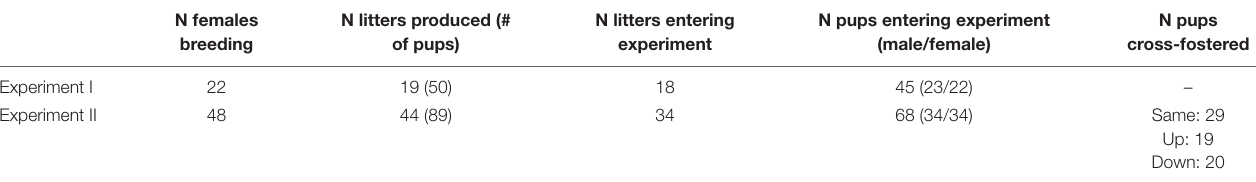
TABLE 1 | Overview of the number of females used for breeding (N females breeding), the number of females that gave birth (N litters produced) and number of pups in brackets. N females N litters produced (# N litters entering N pups entering experiment breeding of pups) experiment